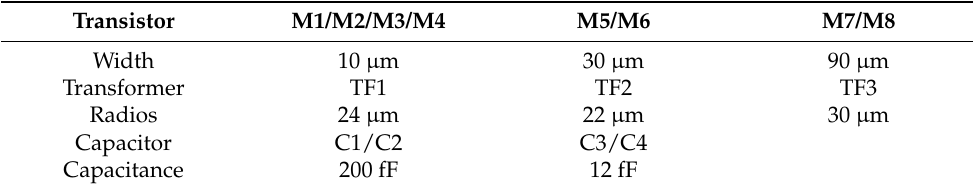
Table 1. Design parameters of the proposed injection-locking transmitter